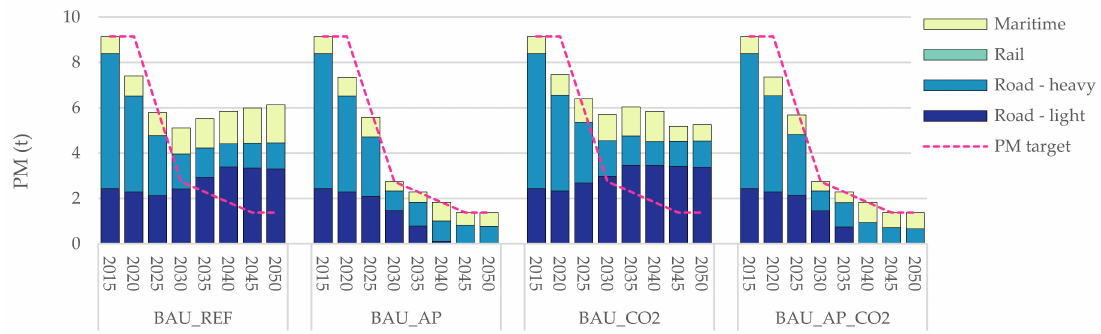
Figure 7. By-mode tailpipe particulate matter (PM) emissions in the Business-as-usual (BAU) scenarios (t). Note : Road— heavy = buses, MGVs and HGVs; Road—light = cars and